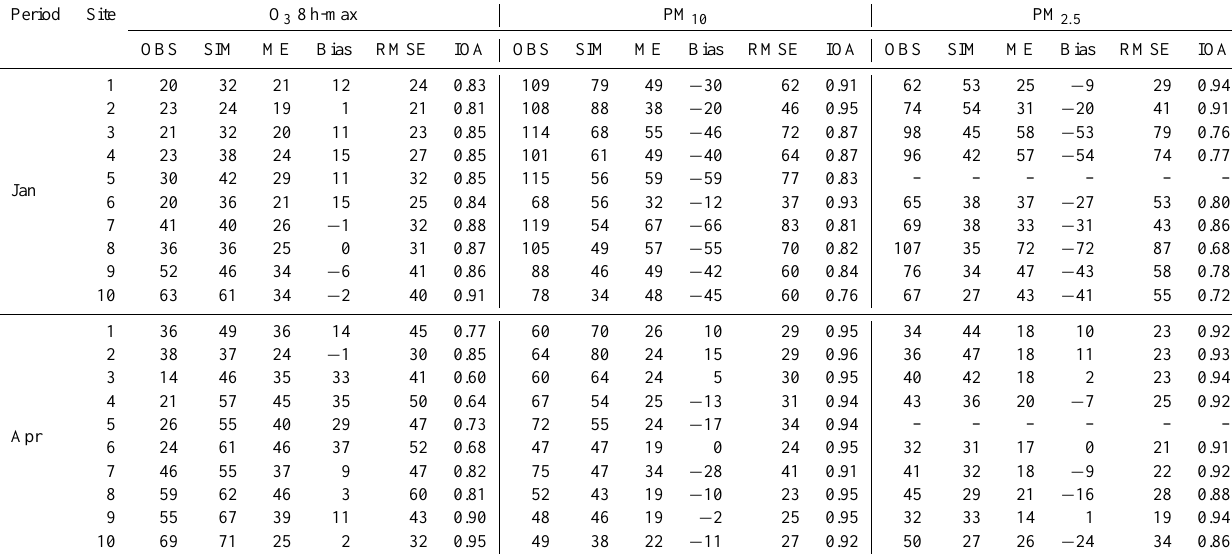
Table 1. Statistical evaluation of pollutant simulation in January and April 2010 (µgm − 3 ) .